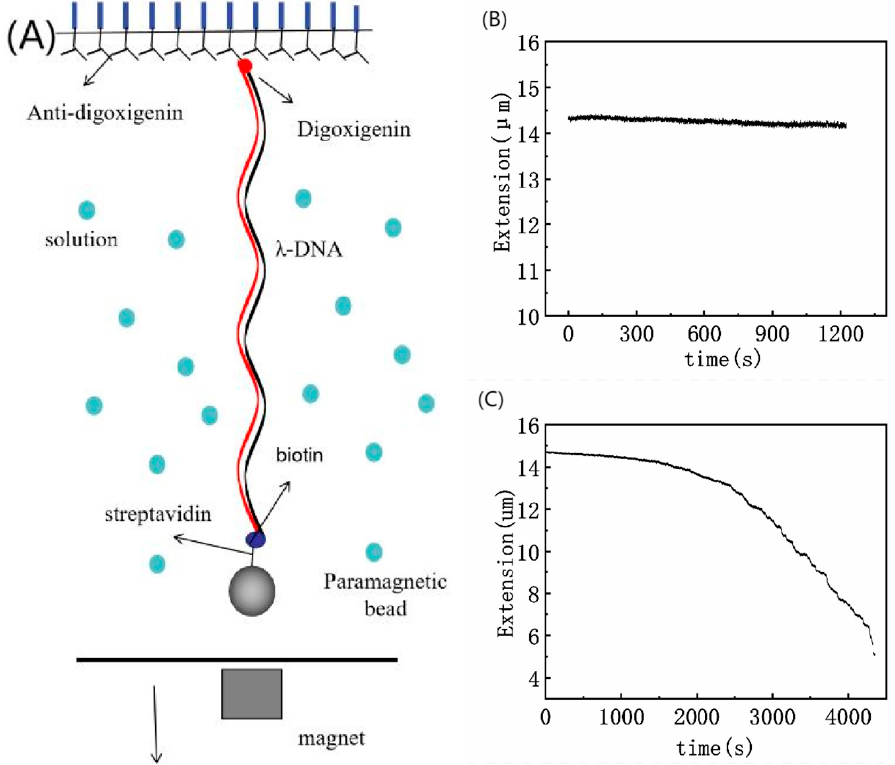
Figure 1. ( A ) A schematic diagram of the experiment setup; The curves of condensing forces are shown in ( B ) a non-condensing curve and ( C ) a condensing curve. DNA extension-time curve measured by MT in DNA compaction process with lysozyme.